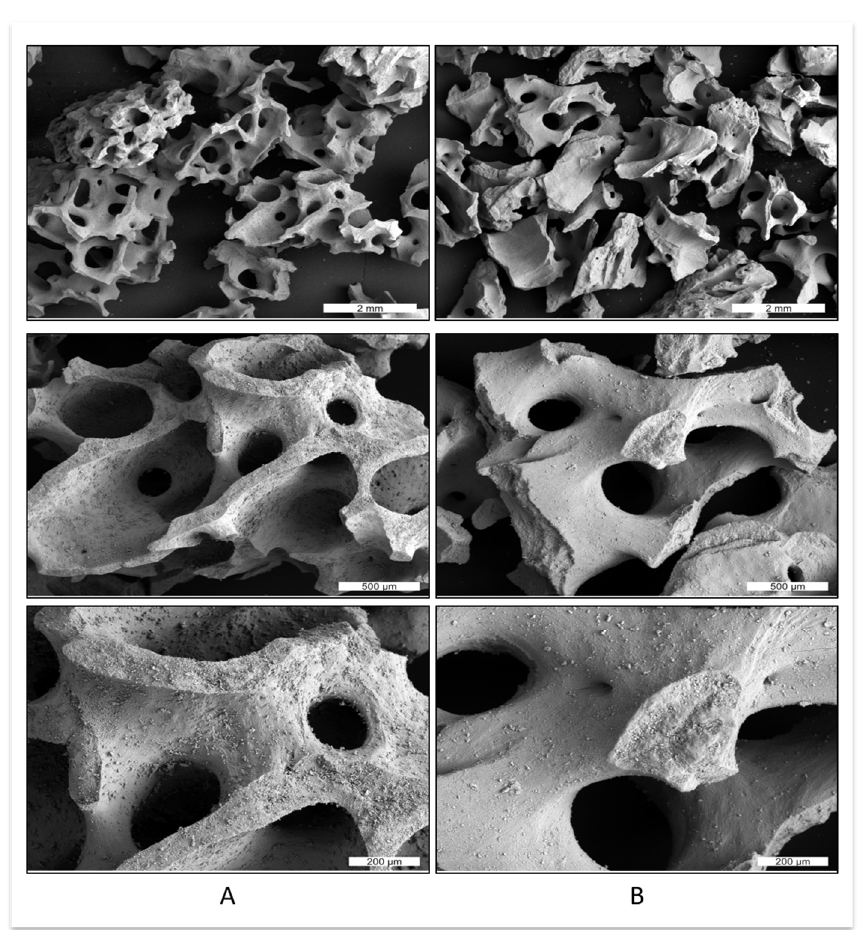
Figure 6. Comparison of two different xenogeneic bone graft materials: ( A ) sintered xenograft (Cerabone ® ) and ( B ) non-sintered xenograft (BioOss ® ). For example, xenograft ( A ) has a rougher surface in comparison to xenograft ( B ).